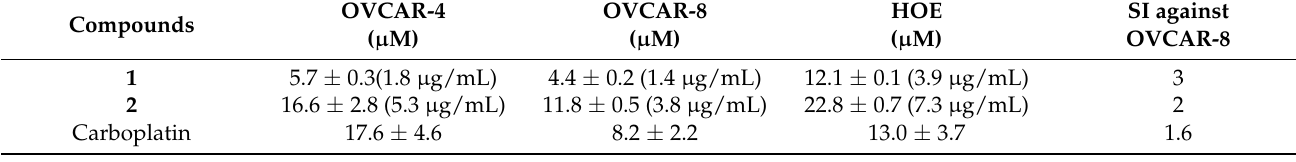
Figure 2. Mean concentration-response curve of compound 1 ( A ) and 2 ( B ) in OVCAR-4 and OVCAR-8 ovarian cancer cells and HOE. IC 50 values determined are listed in Table 1. Table 1. The growth inhibitory activities of isolated compounds ( 1 and 2 ) from J. insularis in OVCAR-4, OVCAR-8 cancer cell lines and HOE cells. The selectivity index (SI) (the ratio of IC 50 against HOE cells to IC 50 against OVCAR-8) are indicated.